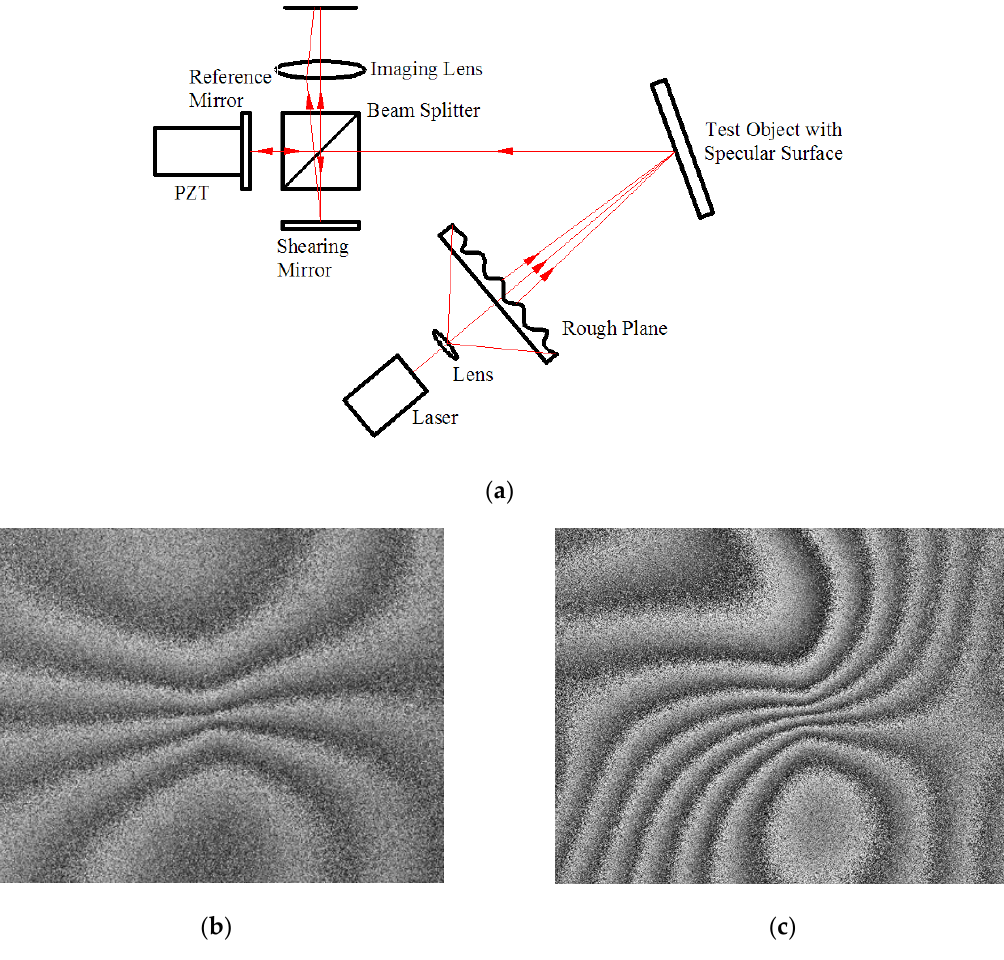
Figure 12. ( a ) The modified shearography system for specular surfaces; ( b ) experimental result of the metal plate with a cone-shape deformation; ( c ) experimental result of the metal plate with an irregular deformation.